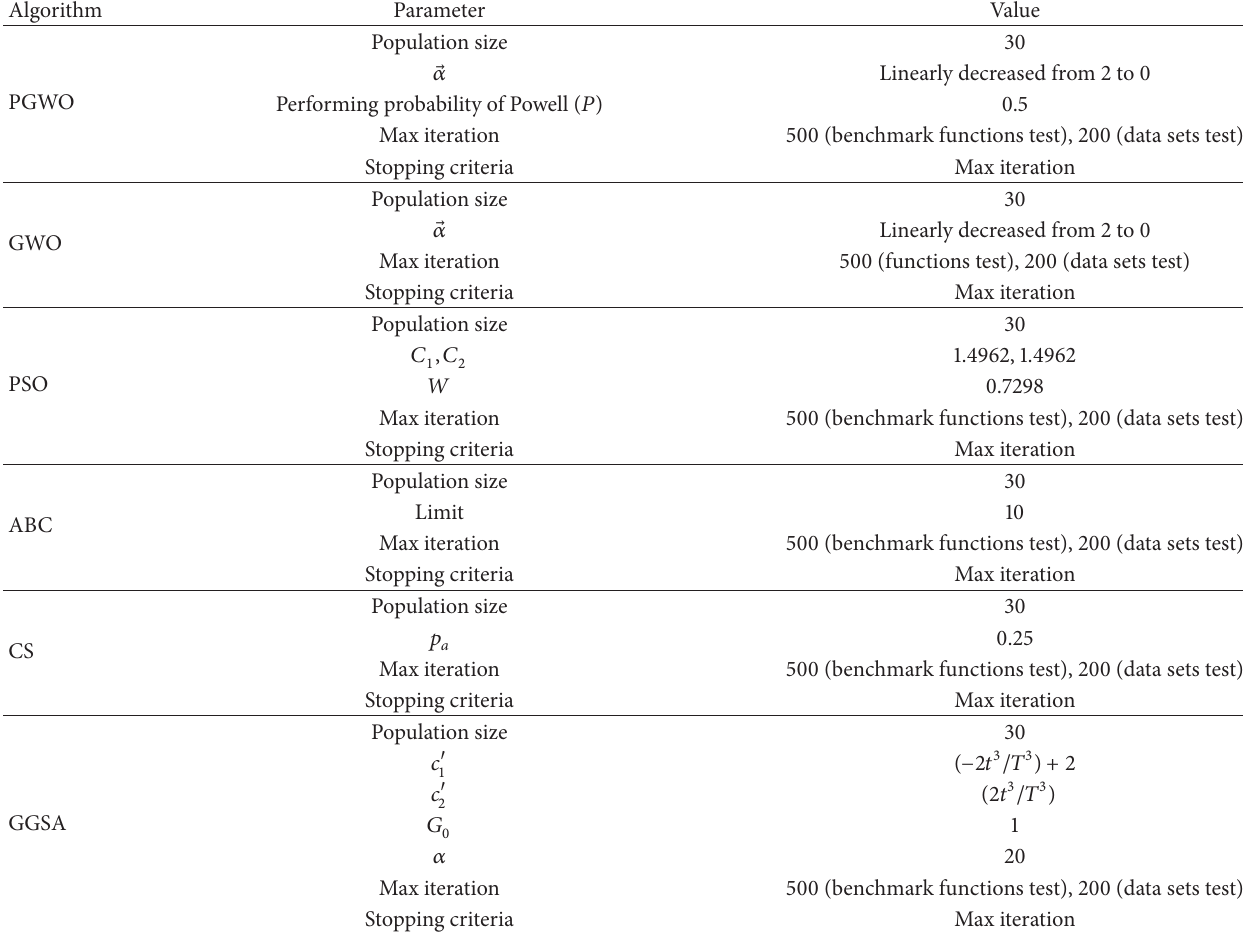
Table 2: Initial parameters of